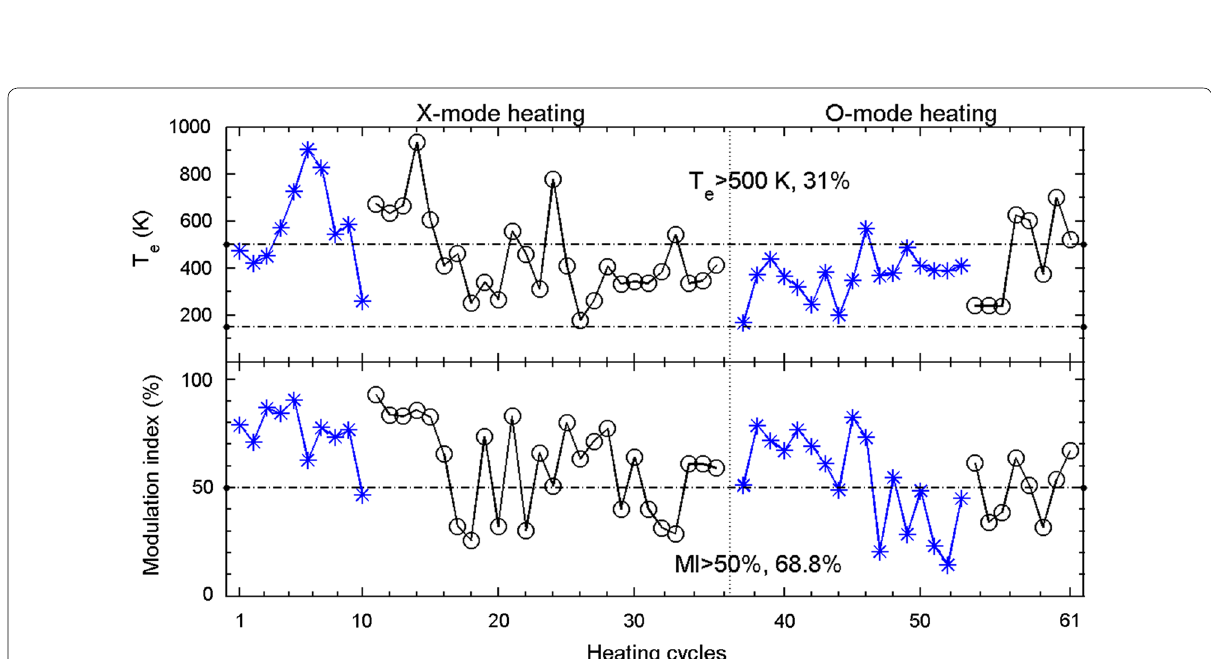
Fig. 7 Panels 1 and 2 show the enhanced electron temperature ( T e ) and PMSE modulation index (MI), respectively, for corresponding heating cycles of case 1. The percentage shown in panel 1 corresponds to number of cycles where T e > 500 K, while in panel 2 corresponds to number of cycles where PMSE modulation index, MI > 50%. The asterisks represent the measurements at transmitter frequency 5.423 MHz, whereas the circles represent the measurements at 7.953 MHz. The vertical dash line is used to separate the measurements of X- and O -modes